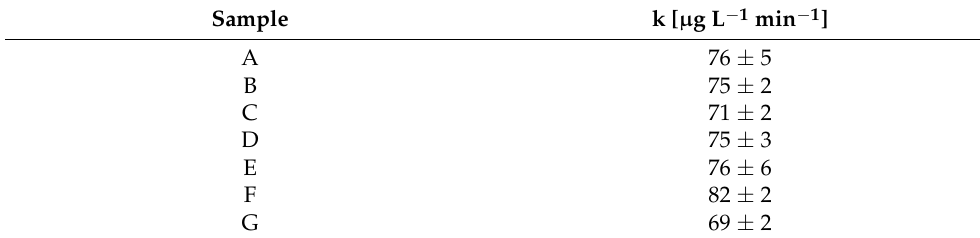
Table 2. Reaction constants from the linear part of photocatalytic degradation ( γ (TiO 2 ) = 0.25 g/L). Sample